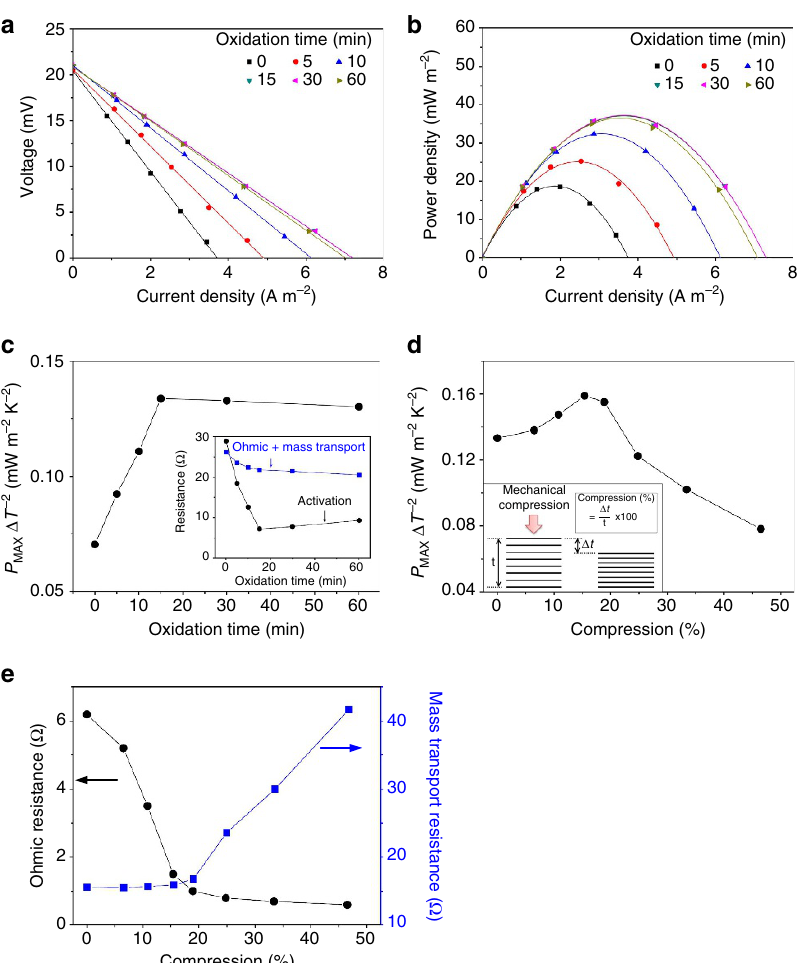
Figure 3 | The effect on thermocell performance of oxidation and compression of the CNTaerogel. ( a ) Cell voltage versus current density and ( b ) cell power density versus current density for samples having different thermal oxidation times. ( c ) Maximum power density normalized to the inter-electrode temperature difference ( P MAX / D T 2 ) as a function of thermal oxidation time. (Inset: the dependence of activation resistance and the sum of ohmic and mass transport resistance on thermal oxidation time). ( d ) P MAX / D T 2 generated by the thermocell as a function of the per cent mechanical compression of cell electrodes. The inset illustrates the mechanical compression of a planar CNT aerogel electrode. ( e ) The dependence of ohmic and mass transport resistance on the compressive strain shown in d